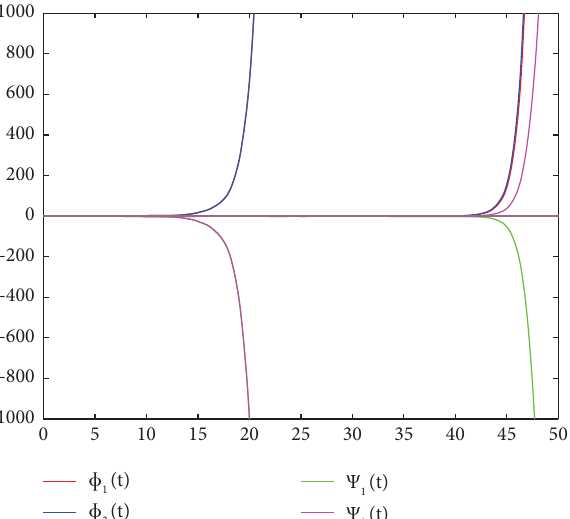
Figure 5: Te state of system (81) with T � 0 . 007, Y 􏽮 􏽯 � 2 ξ + Θ ξ